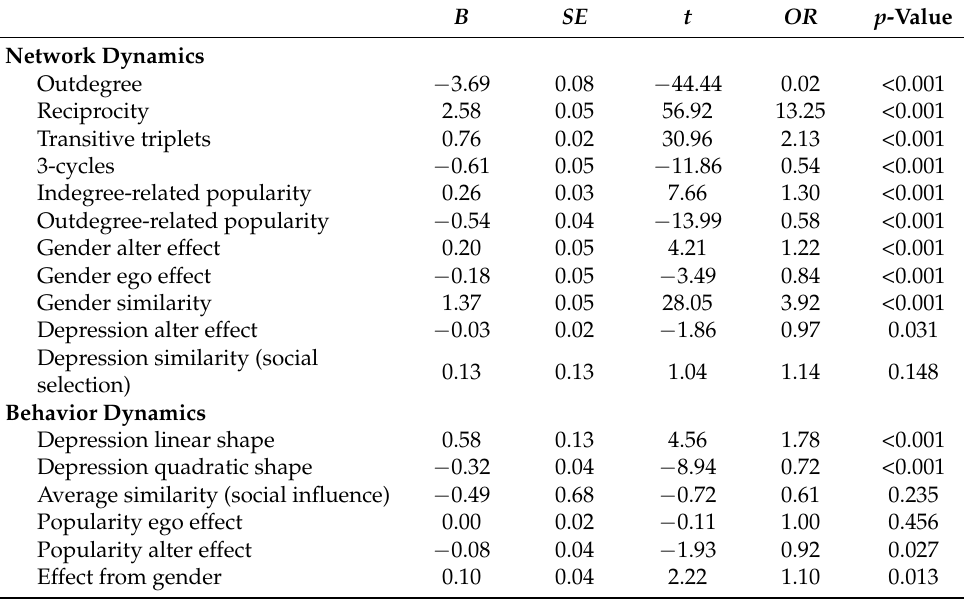
Table 4. The stochastic actor-based model of the peer networks and depressive symptoms of adoles- cents under chronic